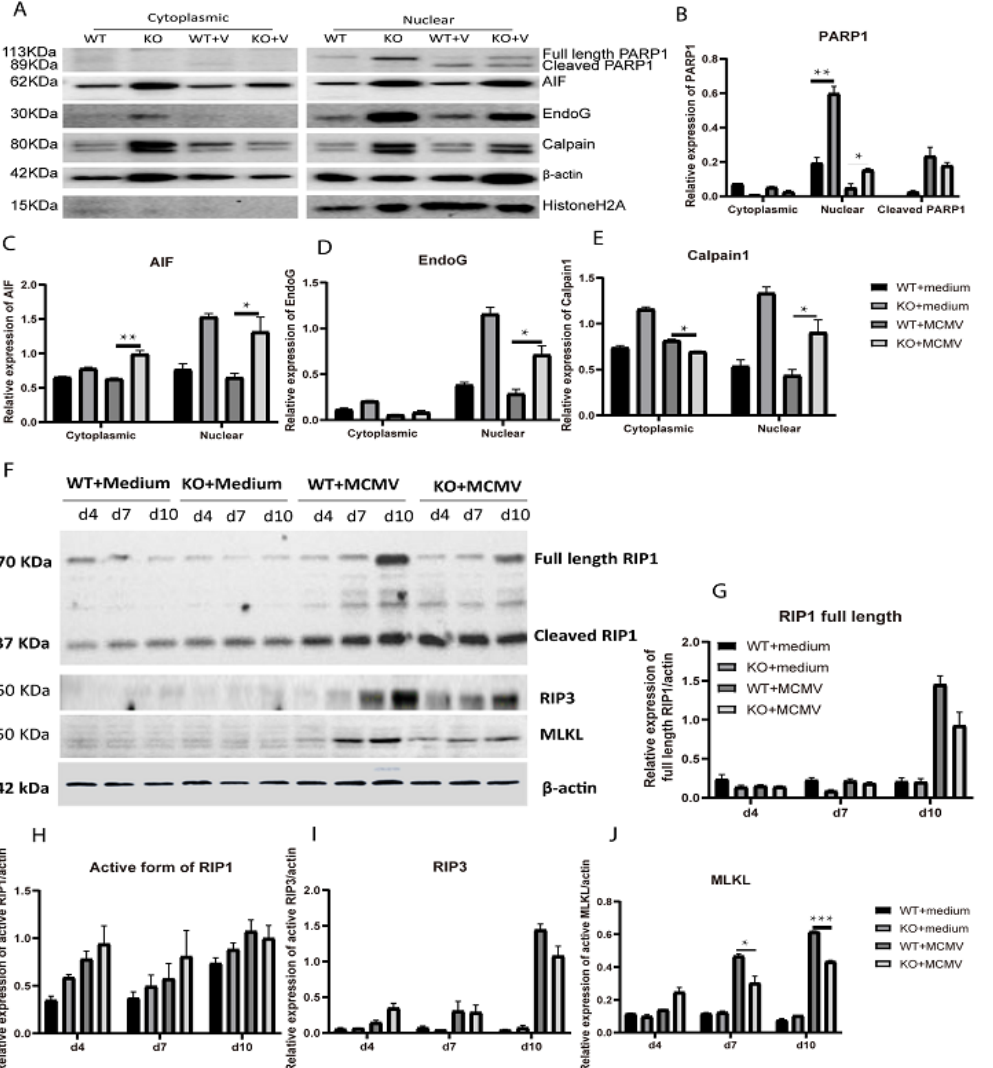
Figure 6. AIF mediated cell death and necroptosis. ( A – E ) Western blot showing expression of PARP1, AIF, EndoG and Calpain in the cytoplasmic and nuclear fractions of eyes of mock-infected or MCMV-infected (+v) IS WT or KO mice, at day 7 p.i. ( A ); ratio of PARP1 to β -actin for cytoplasmic fractions and ratio of PARP1 to HistoneH2A for nuclear fractions ( B ); ratio of AIF to β -actin for cytoplasmic fractions and ratio of AIF to HistoneH2A for nuclear fractions ( C ); ratio of EndoG to β -actin for cytoplasmic fractions and ratio of EndoG to HistoneH2A for nuclear fractions ( D ); ratio of Calpain to β -actin for cytoplasmic fractions and ratio of Calpain to HistoneH2A for nuclear fractions ( E ); ( F – J ) Western blot of RIP1, RIP3, and MLKL in medium-injected or MCMV-injected eyes of WT or KO mice at day 4, 7, and 10 p.i. ( F ); ratio of full length RIP1 to β -actin ( G ); ratio of cleaved RIP1 to β -actin ( H ); ratio of full RIP3 to β -actin ( I ); ratio of MLKL to β -actin ( J ). Data are shown as mean ± SEM ( n = 3). * p < 0.05, ** p < 0.01, *** p < 0.001 by 2-tailed t